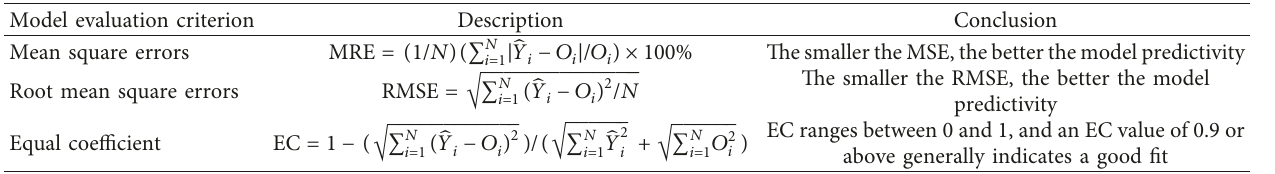
Table 7: Summary of model evaluation criteria.